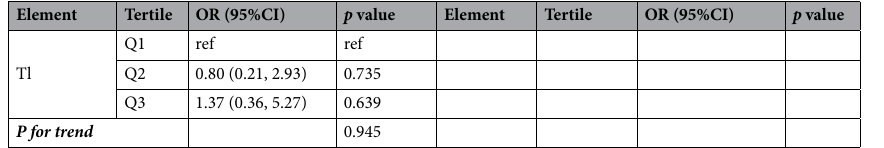
Table 4. Adjusted odd ratio (OR) for the risk of GDM according to the tertiles of fingernail elemental concentration. Odd ratio adjusted for education level, income, passive smoking, physical activity pattern, family history of diabetes, parity, age and pre-pregnancy BMI. ref: reference group. p for trend was adjusted by FDR correction. Bold indicates p value < 0.05 by logistic regression